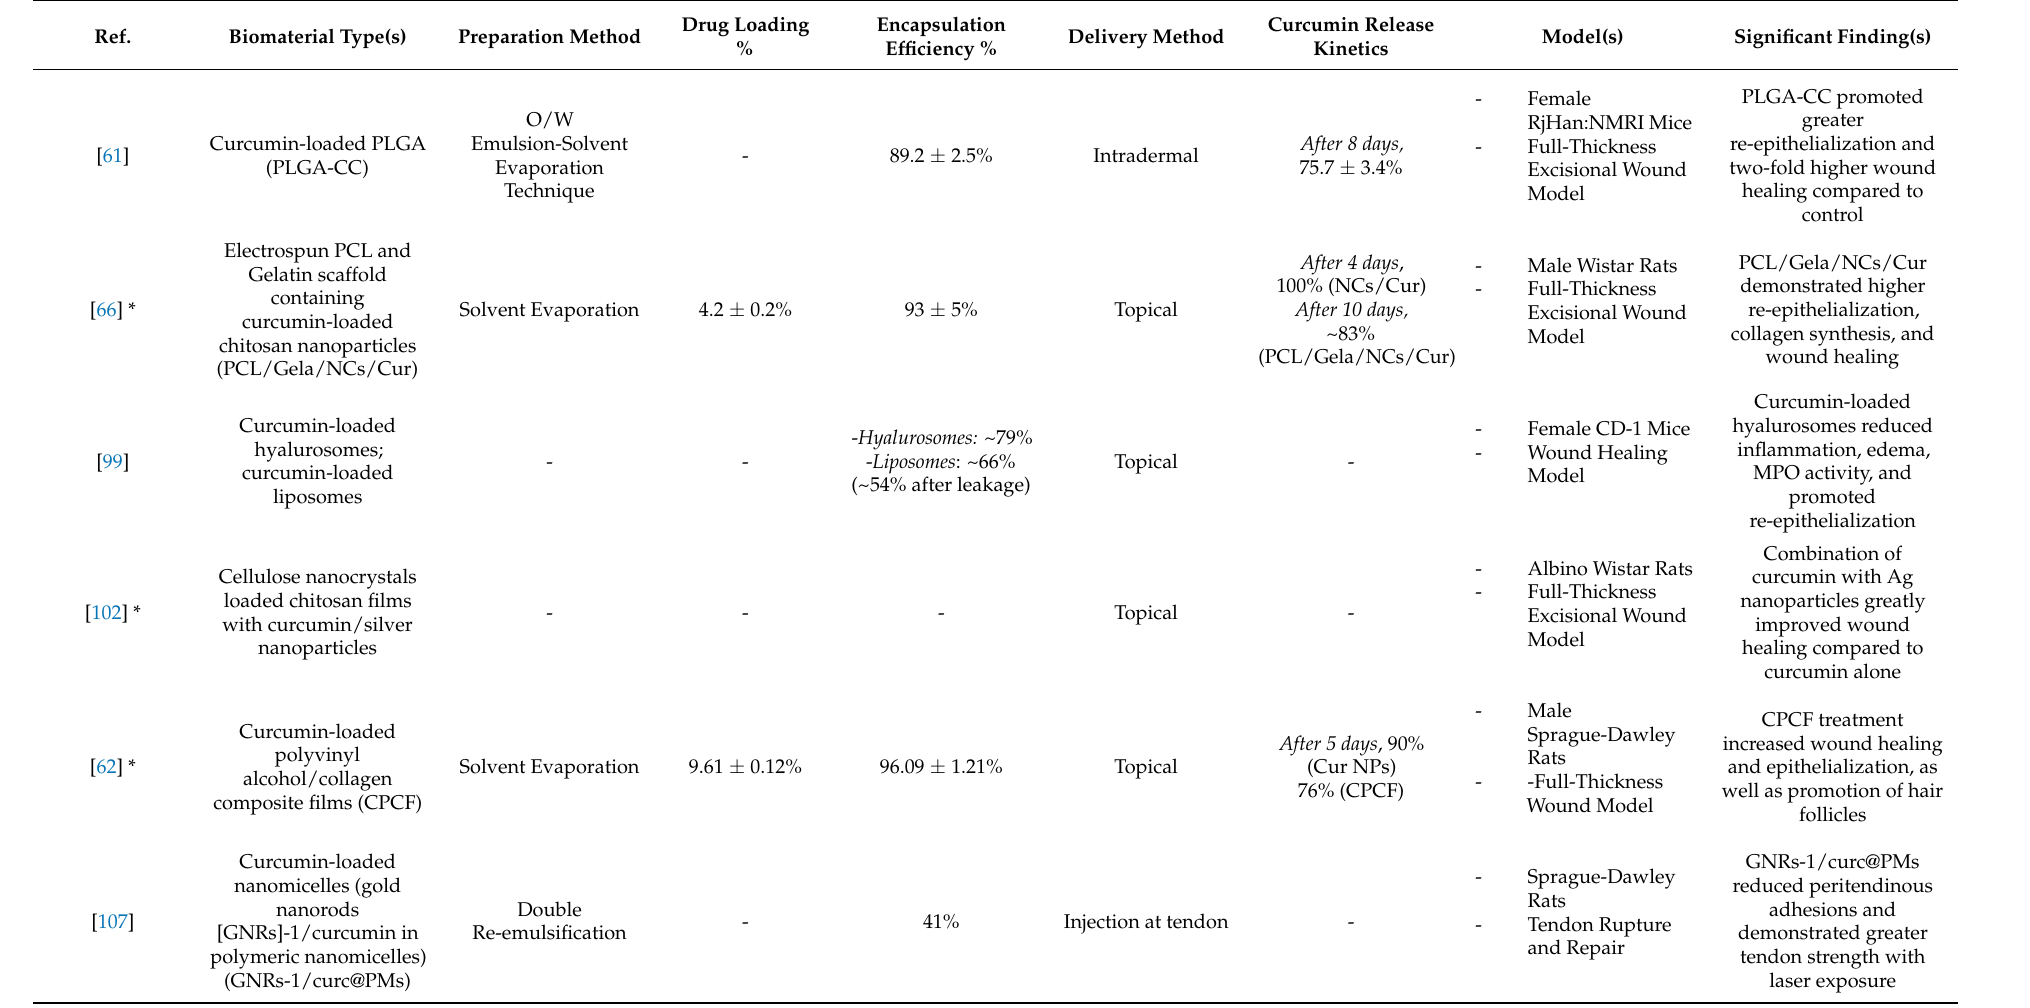
Table 3. Curcumin delivery from nanoparticle